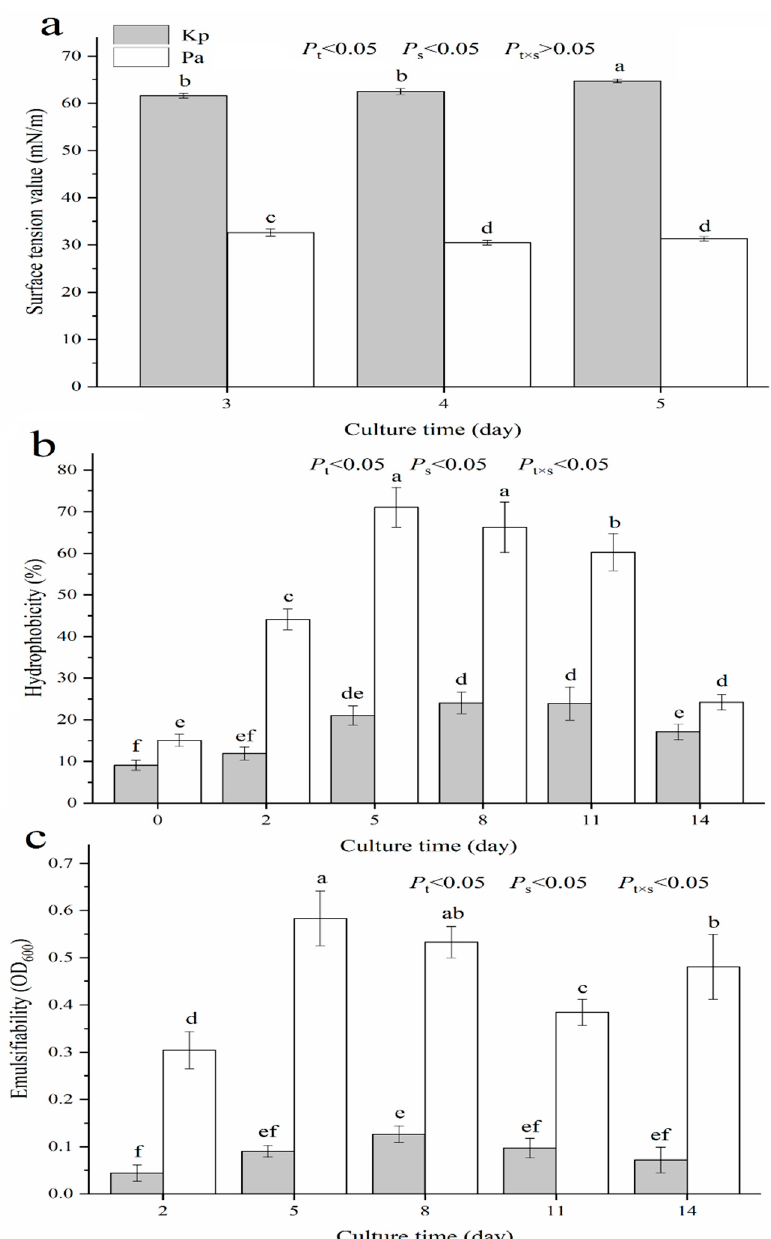
Figure 5. Differences in surface tension ( a ), hydrophobicity ( b ), and emulsifiability ( c ) between the two strains, Kp and Pa.